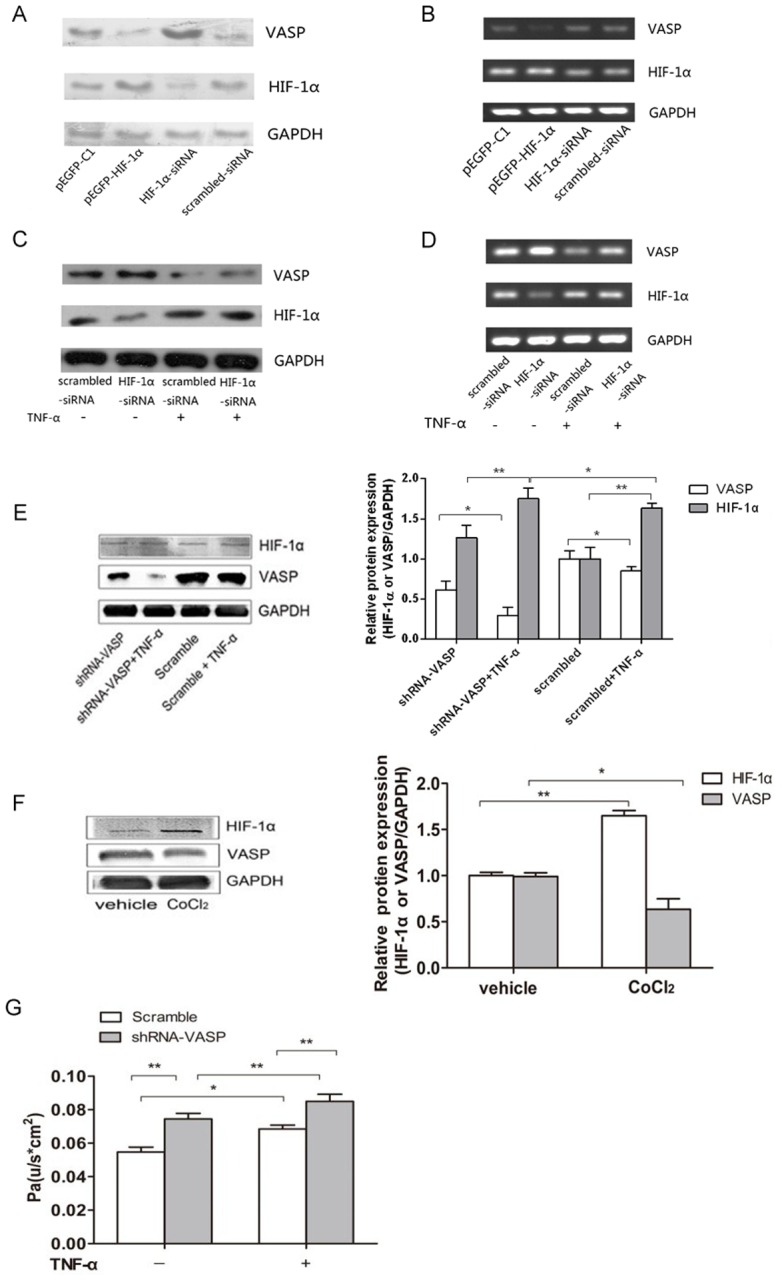
TNF-α increased A549 permeability by repressing VASP expression, through the activation of HIF-1α.(A) A549 cells were transfected with siRNA-HIF-1α or pEGFP-C1-HIF-1α for 24 hours as indicated. Scrambled siRNA and pEGFP-C1 vector were used as controls. The HIF-1α and VASP protein expression levels were then determined by western blotting. GAPDH served as a loading control. (B) A549 cells were transfected with siRNA-HIF-1α or pEGFP-C1-HIF-1α for 24 hours as indicated. HIF-1α and VASP mRNA expression levels were then determined by RT-PCR. Figure 2A and 2B indicate that VASP expression of both mRNA levels and protein levels were repressed by HIF-1α and that VASP expression was dramatically activated by HIF-1α knockdown in A549 cells. In contrast, HIF-1α overexpression led to the decreased VASP expression. (C) Cells were treated with TNF-α after transfection with siRNA-HIF-1α for 24 h. Scrambled siRNA was used as a control. The HIF-1α and VASP protein expression levels were then determined by western blotting. (D) Cells were treated with TNF-α after transfection with siRNA-HIF-1α for 24 h. Scrambled siRNA was used as a control. The HIF-1α and VASP mRNA expression levels were then determined by RT-PCR. Figure 2C and 2D indicate that in the absence of TNF-α, the expression of both HIF-1α and VASP were maintained at moderate protein levels and the knockdown of HIF-1α led to increased VASP expression in A549 cells. Upon stimulation by TNF-α, the level of HIF-1 α was elevated accompanied by a suppression of VASP expression. However, the suppression of VASP by TNF-α could be relieved through HIF-1α knockdown. (E) A549 cells were transfected with shRNA-VASP or scrambled shRNA and then treated with 10 ng/mL TNF-α or untreated for 24 hours as indicated. The HIF-1α and VASP expression levels were then determined by western blotting. In the absence of TNF-α, VASP expression in the shRNA-VASP group decreased by 15.6% versus the scrambled group (**p<0.01). VASP expression in the shRNA-VASP+TNF-α group was 70.4% lower than that in the scrambled+TNF-α group (*p<0.05). The transfection of shRNA-VASP did not affect the HIF-1α expression level (scrambled vs. shRNA-VASP, p>0.05; scrambled+TNF-α vs. shRNA-VASP+TNF-α, p>0.05). Conversely, TNF-α stimulation dramatically elevated HIF-1α expression (scrambled vs. scrambled+TNF-α, **p<0.01; shRNA-VASP vs. shRNA-VASP+TNF-α, *p<0.05). (F) A549 cells were exposed to 200 µg/mL CoCl2 or vehicle for 24 hours. The HIF-1α and VASP expression levels were then detected via western blotting. HIF-1α expression increased by 64.9% in the CoCl2 group compared with the vehicle group (**p<0.01), whereas VASP expression decreased by 36.7% in the CoCl2 group compared with the vehicle group (*p<0.05). GAPDH served as a loading control. Representative blots from three independent experiments with similar results are shown. The relative protein expression levels obtained for HIF-1α or VASP/GAPDH were used in bar graphs B and C. (G) A549 cells were transfected with shRNA-VASP or scrambled shRNA and then treated with 10 ng/mL TNF-α or untreated for 24 hours as indicated. The paracellular permeability was detected via a monolayer paracellular cells permeability assay and expressed as Pa. The Pa in the shRNA-VASP group increased significantly compared with the scrambled group, 36.0% in the absence of TNF-α (**p<0.01) and 24.3% in the presence of TNF-α (**p<0.01). The Pa in the shRNA-VASP+TNF-α group was 14.2% higher than that in the shRNA-VASP group (**p<0.01). In addition, TNF-α induced a 25.0% increase in Pa (*p<0.05) between the two scrambled groups. The test was repeated three times with identical results. The data are presented as the mean ± SEM. *p<0.05, **p<0.01.